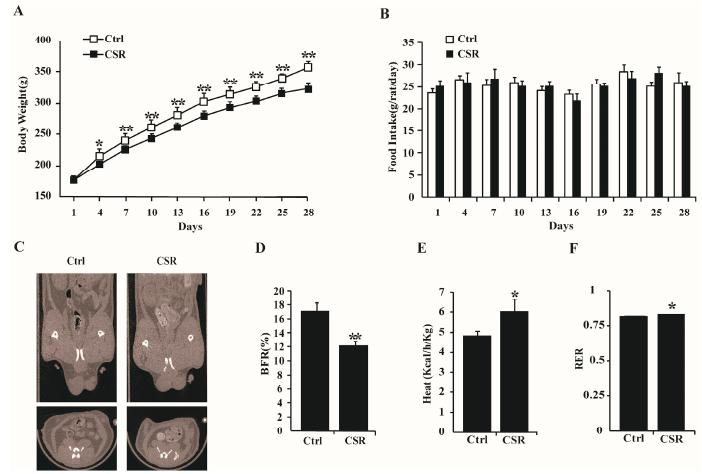
Figure 2. Chronic sleep restriction increased basal metabolism: Body weight ( A ); and food intake ( B ) of control and CSR rats were monitored during chronic sleep loss. White squares = control group; black squares = CSR group. n = 10; ( C ) Reconstructive micro-CT scanning images of abdominal fat in control and CSR rats. n = 5; ( D ) BFR was calculated from ( C ). Heat production ( E ); and RER ( F ) were measured after CSR by metabolic cages. * p < 0.05, ** p < 0.01 vs. control. n = 5.